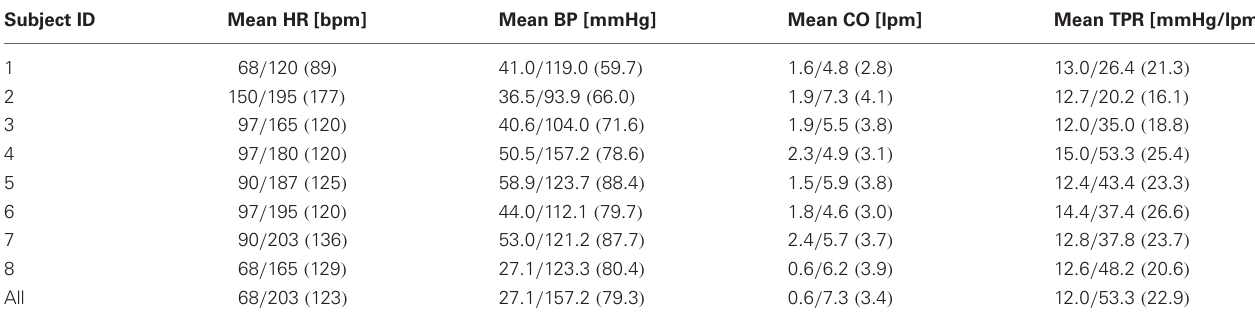
Table 1 | Physiological conditions of experimental swine